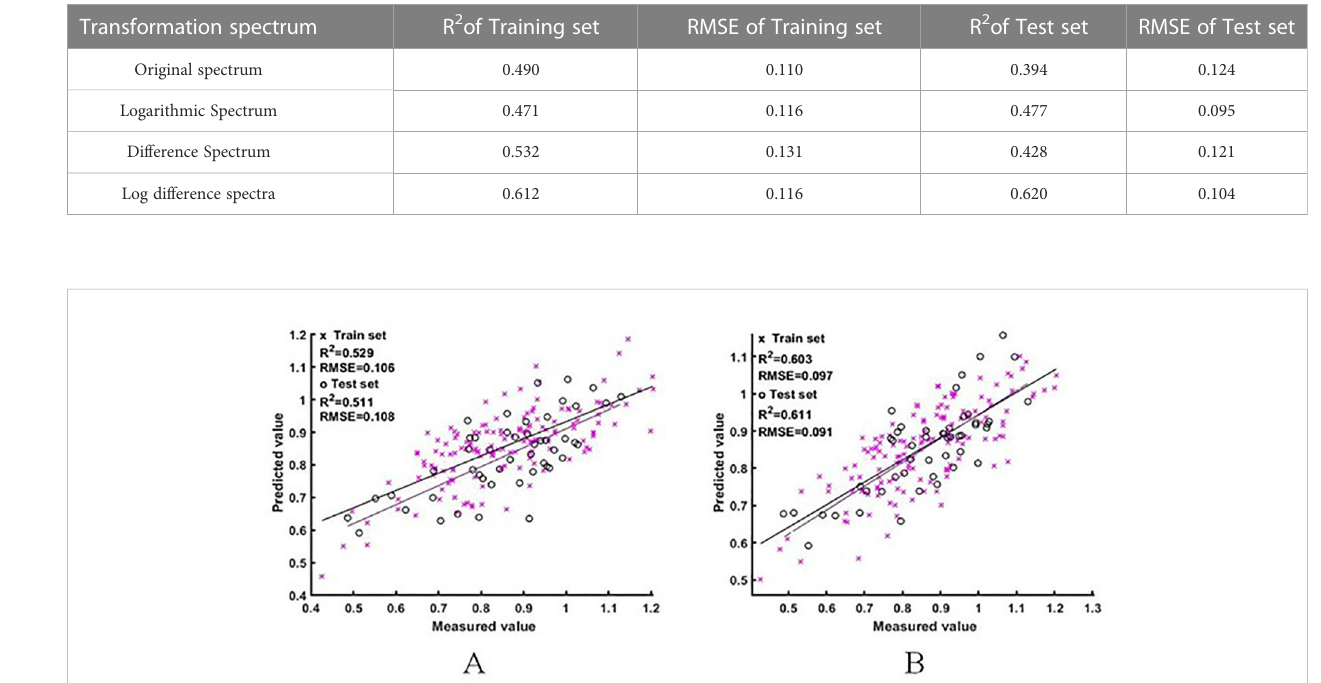
TABLE 3 NNI estimation from encoder feature extraction results to MLR.